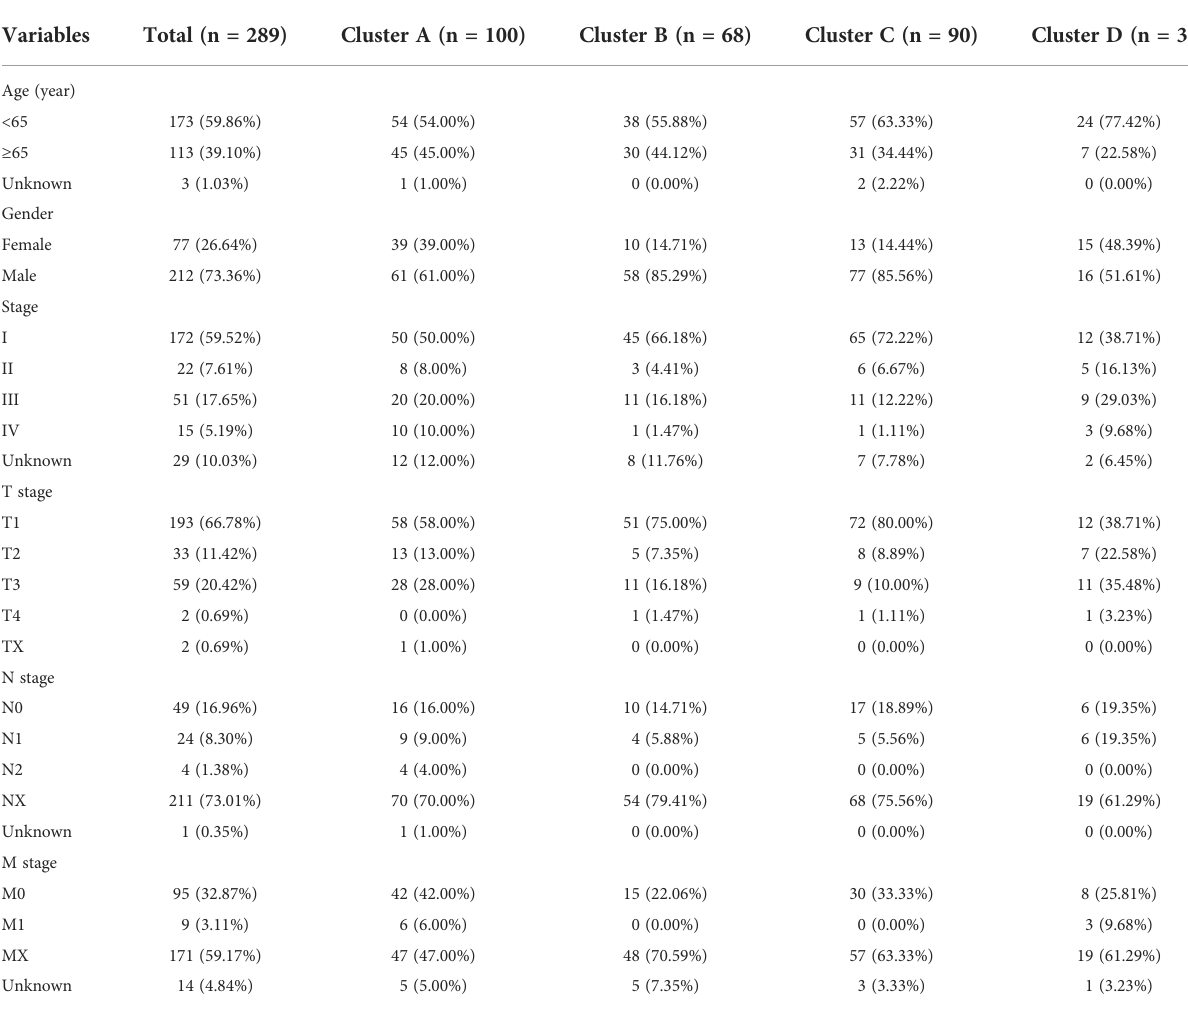
TABLE 1 Clinical characteristics of included patients in the